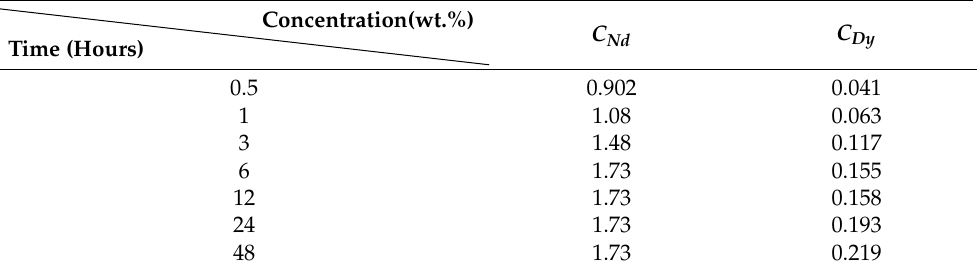
Table 2. The concentration of elements in the Mg region by